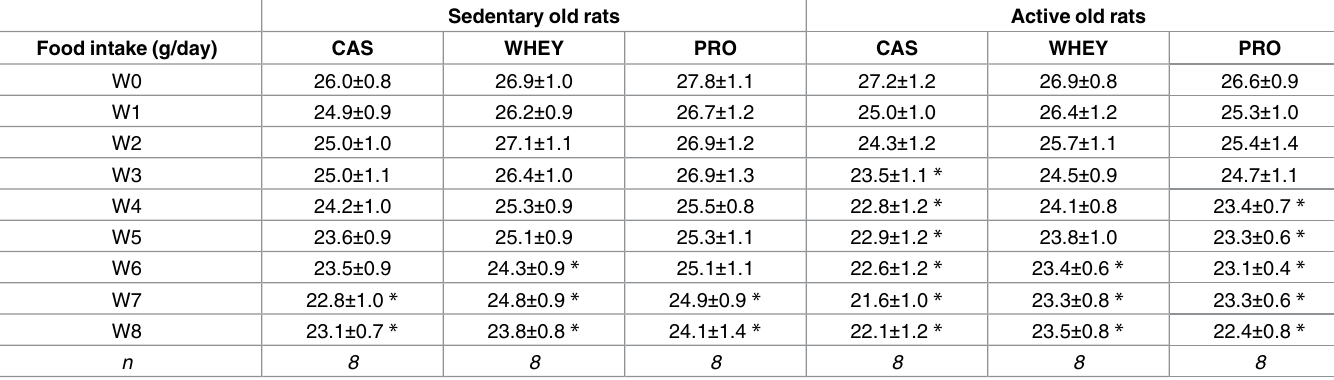
Table 4. Old rats exhibited a decreasein spontaneous daily food intake.